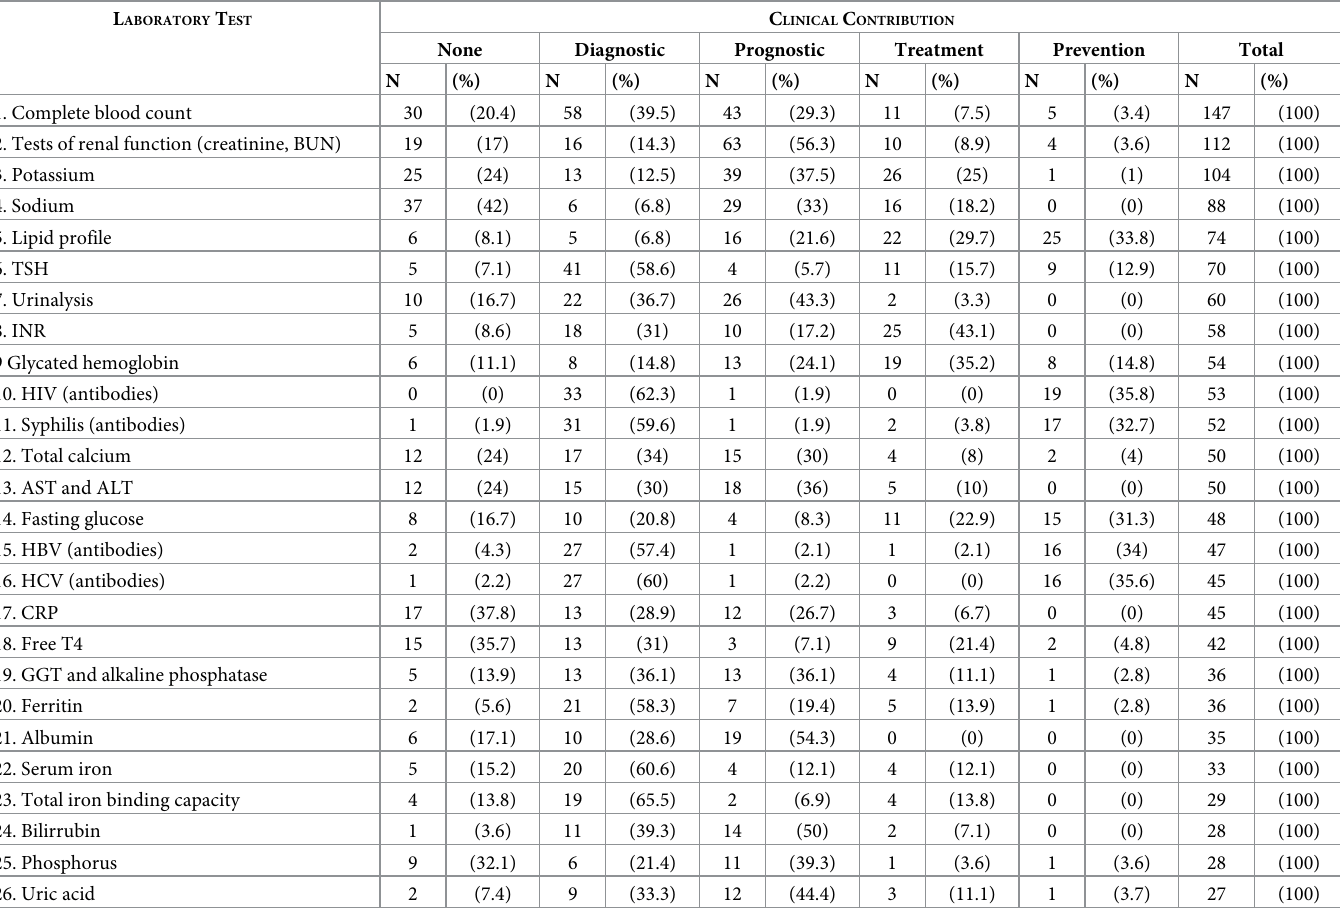
Table 3. Clinical contribution of the tests most frequently ordered and ranked by